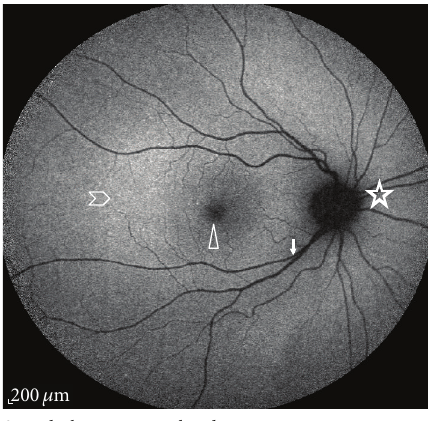
Figure 1: Autofluorescence distribution in a normal eye fundus. It is the highest in the posterior pole and gradually diminishes toward theperiphery;italsoshowshypoautofluorescenceoverthefovea,the optic nerve head, and retinal